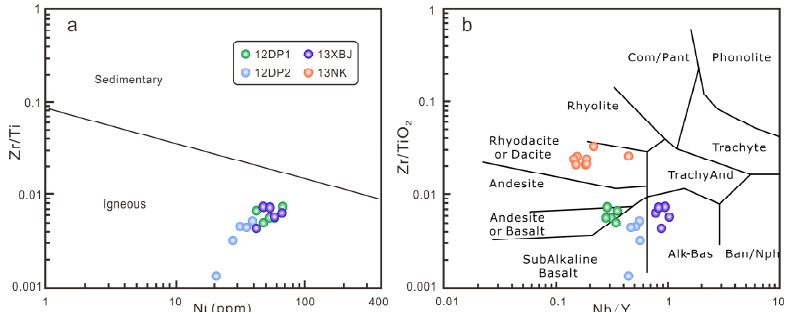
Figure 4. ( a ) Discrimination of volcanic and sedimentary amphibolites, modified after the work in [ 97 ]; ( b ) Classification volcanic rocks using relatively inmobile elements, modified after the work in [ 99 ].